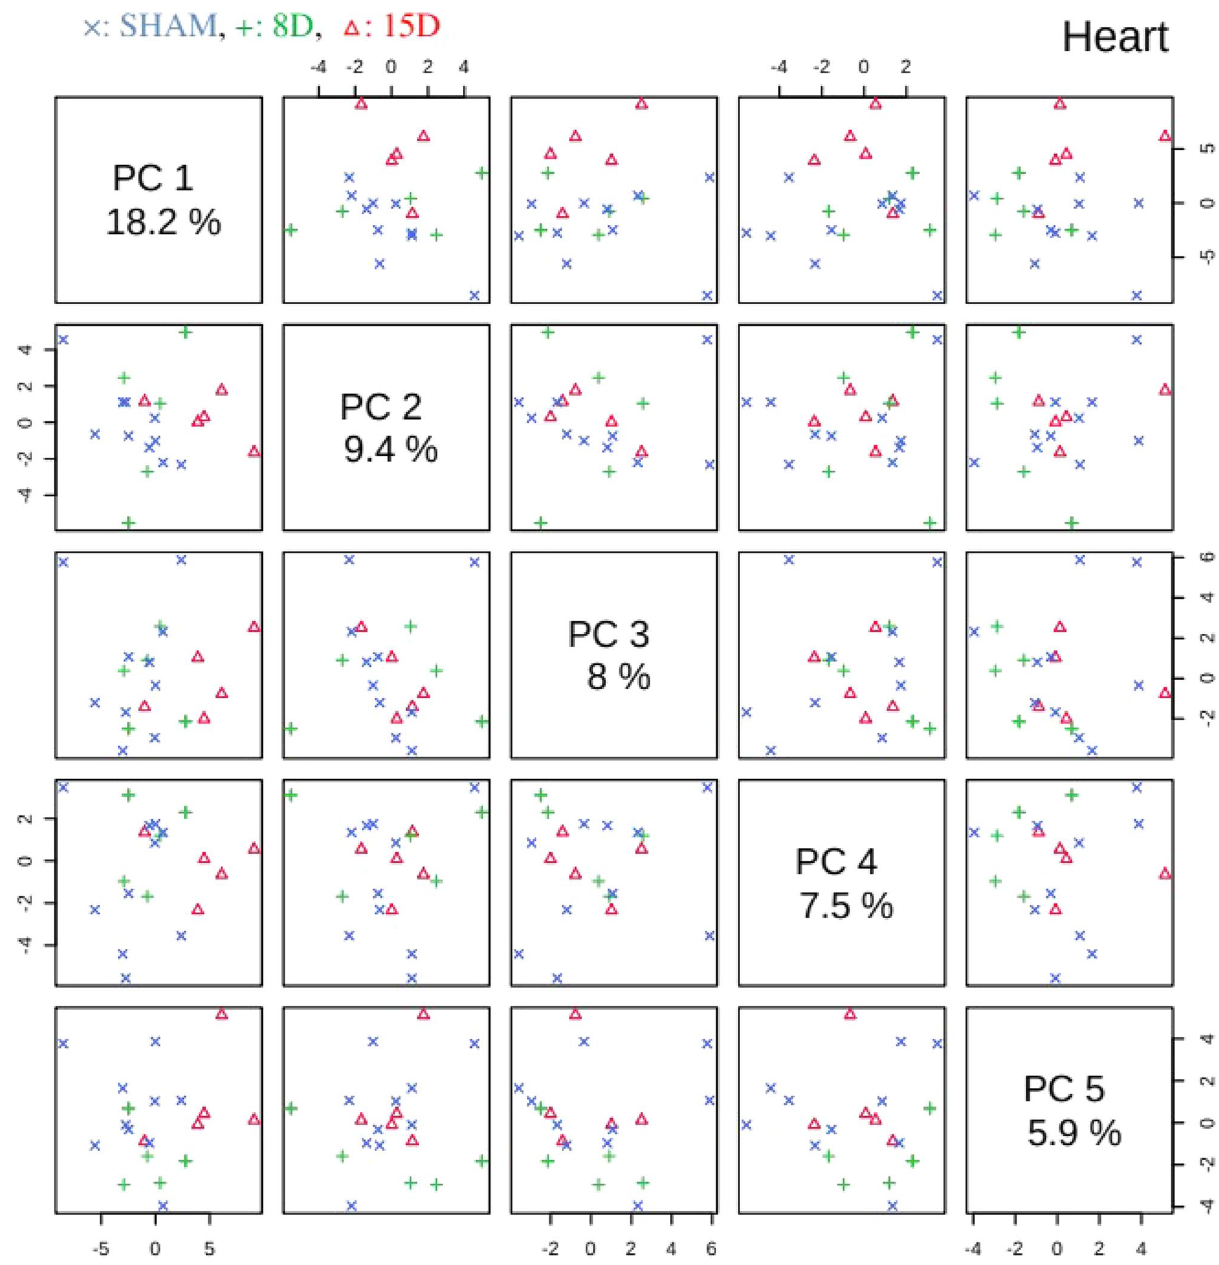
Figure 3. Pairwise score plots between the selected PLS-DA components for heart group. The explained variance of each component is shown in the corresponding diagonal cell. (x: SHAM, + : 8D, (cid:31) :